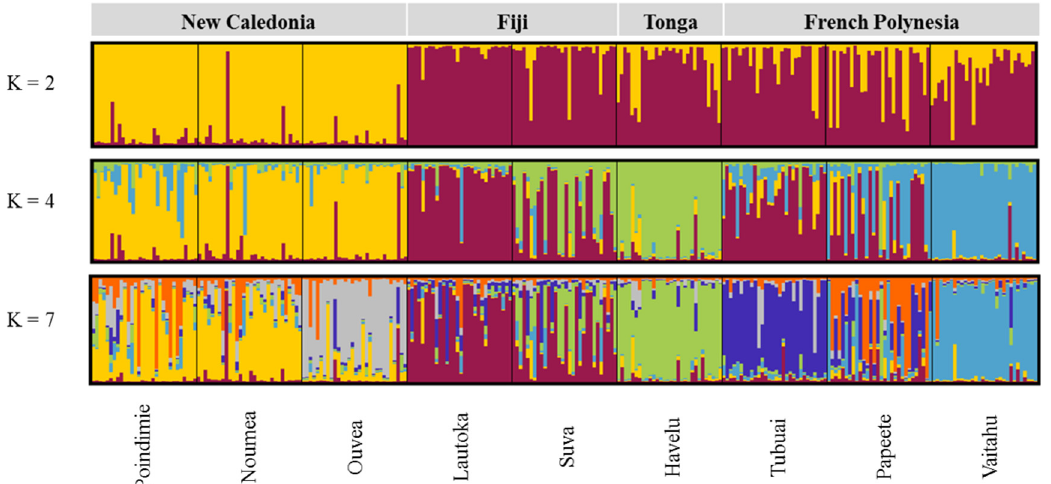
Fig 3. Model-based clustering of 270 Ae . aegypti individuals using STRUCTURE software. Each individual is represented by a single vertical line; sample sites are separated by a black line; the whole sample is divided into K colors representing the number of clusters assumed. The colors show the estimated individual proportions of cluster membership.